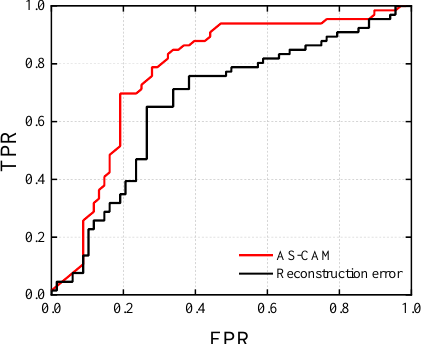
Figure 8. Pixel-level ROC curves with changes in localization